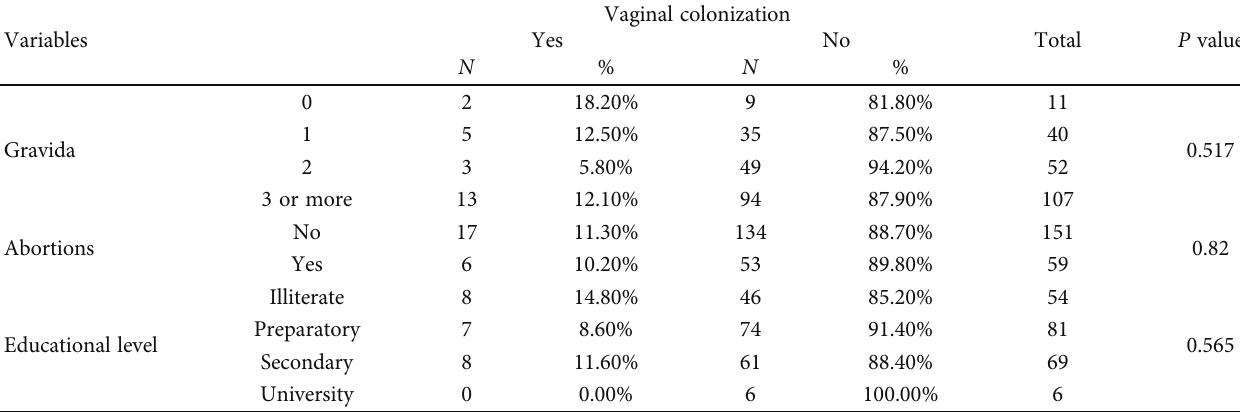
Table 1: Relationship between independent variables and GBS vaginal colonization rate among Yemeni pregnant women in Sana ’ a city. Variables